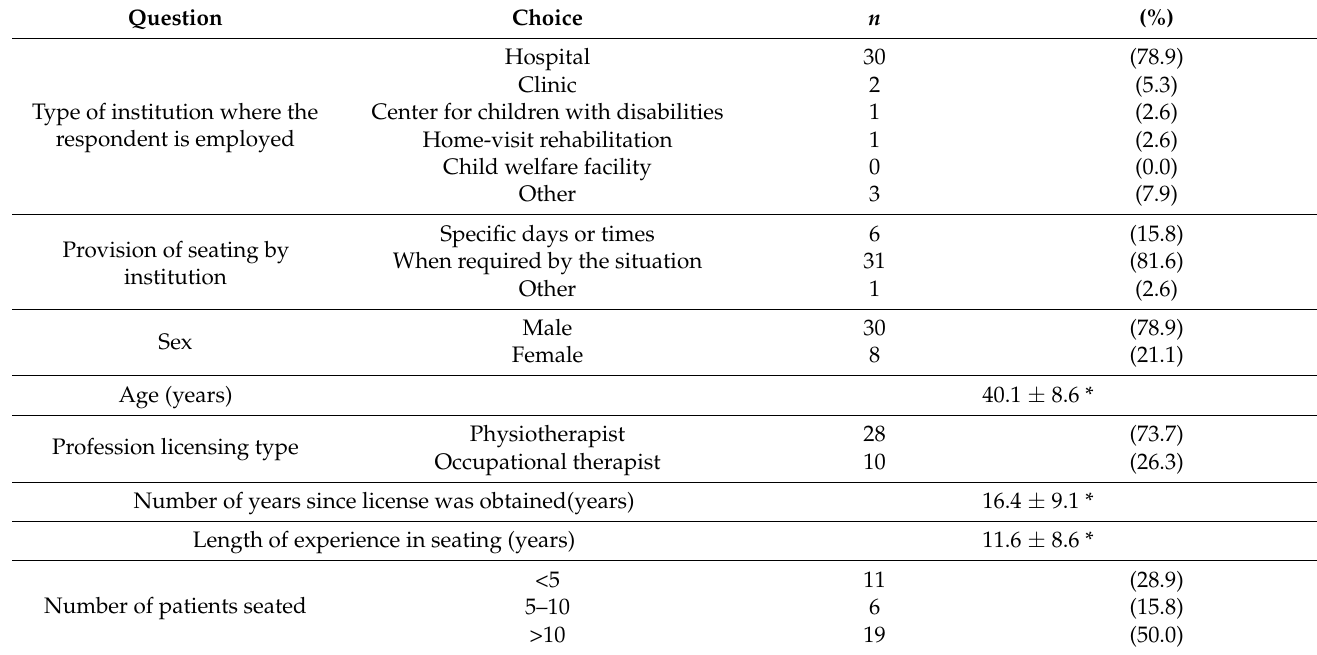
Table 2. Characteristics of respondents ( n =